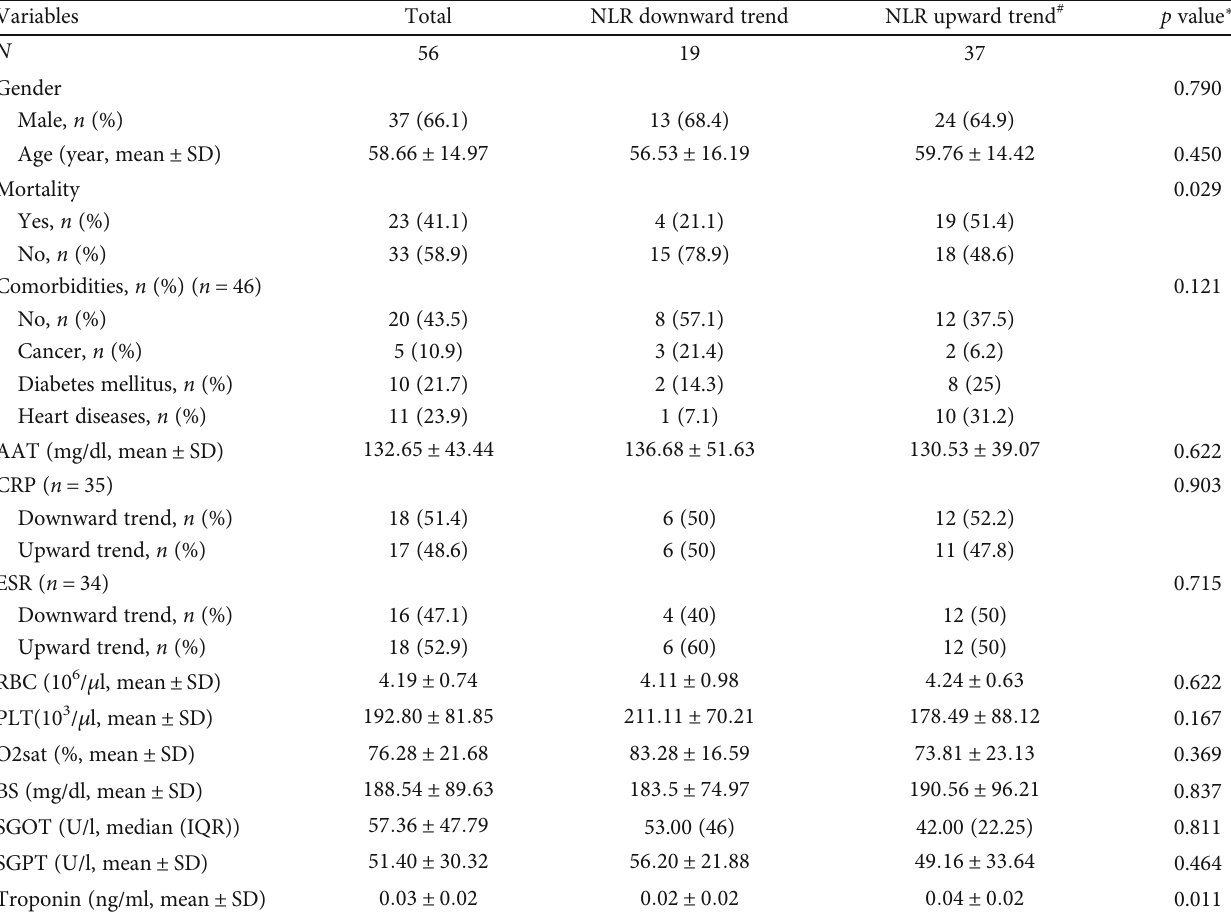
Table 1: Clinical and laboratory analyses of the patients and di ff erences in patients ’ characteristics between NLR downward trend and NLR upward trend